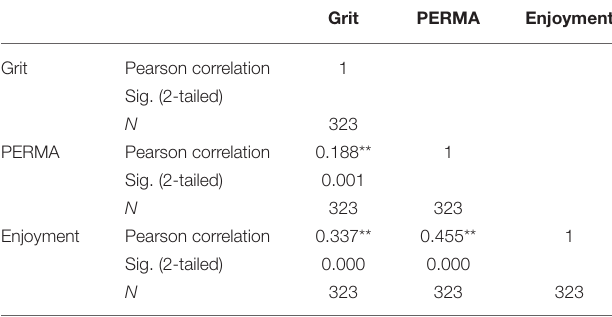
TABLE 4 | Regression results: ANOVA. Grit PERMA Enjoyment